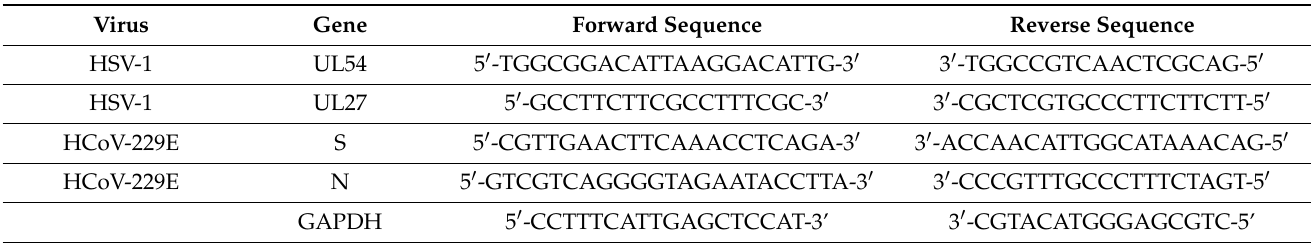
Table 2. Primer sequences of HSV-1 and HCoV-229E used for gene expression analysis.